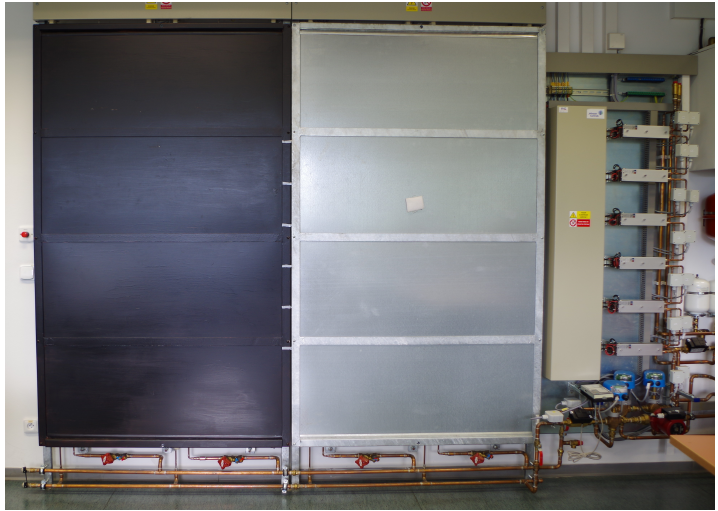
Figure 10. Thermal panels with the original and modified